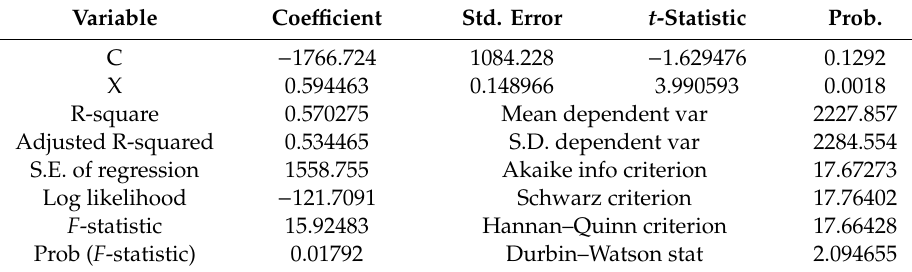
Table 6. Results of canned